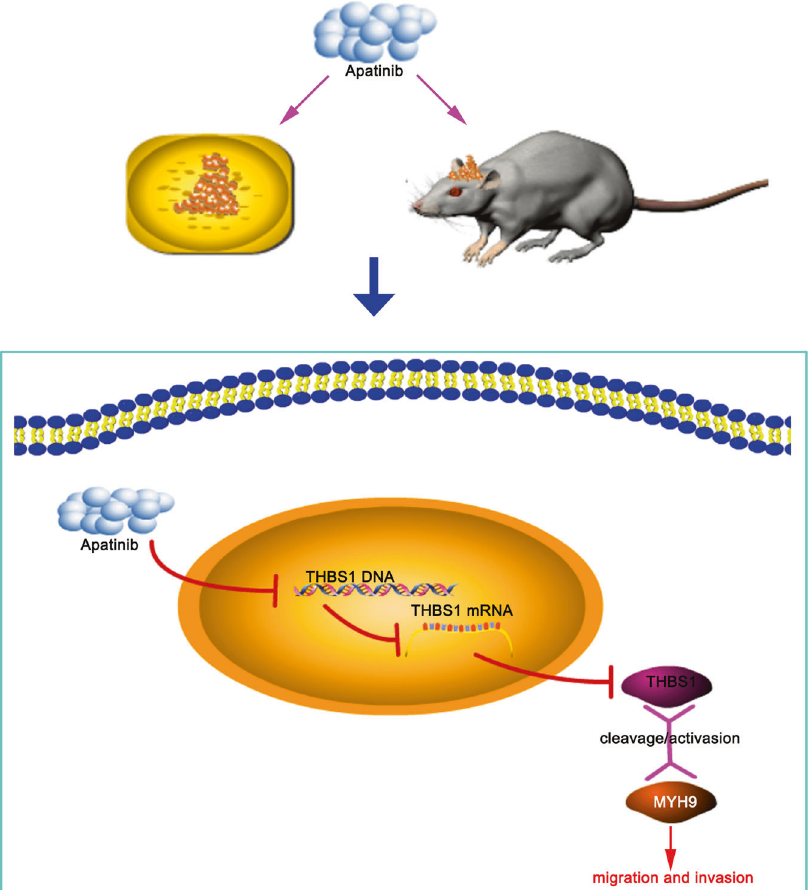
Fig. 9 Experimental mechanism diagram. Schematic diagram illustrating apatinib-mediated inhibition of gliomas in vitro and in vivo and apatinib-mediated regulation of the THBS1/MYH9